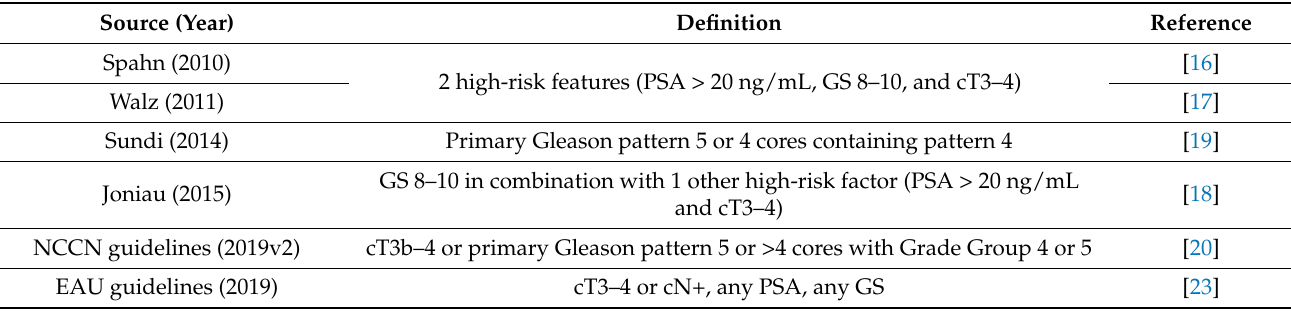
Table 1. Definition of very high-risk prostate